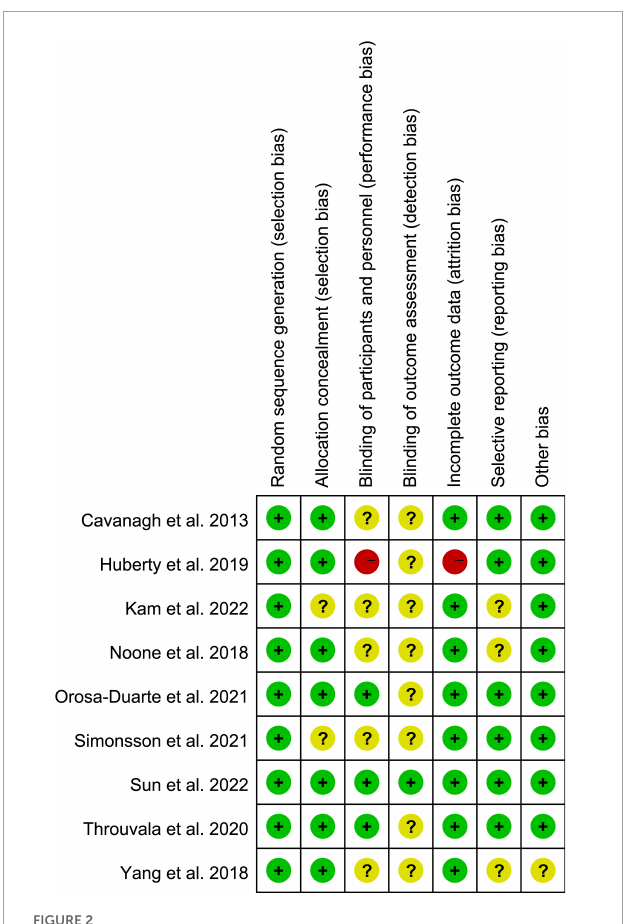
FIGURE2 Summary of bias risk for included